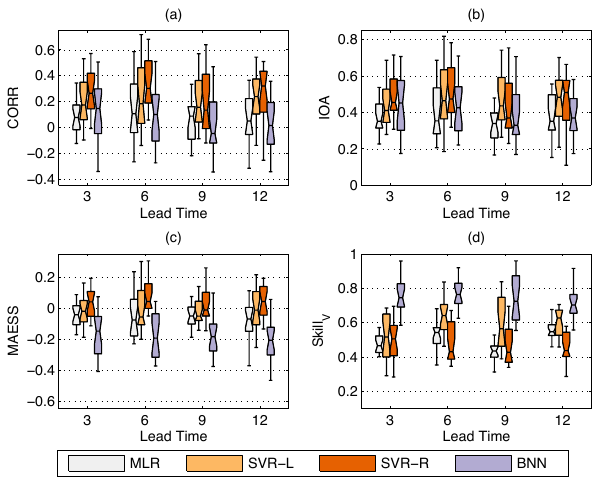
Fig. 3. Same as Fig. 2, except over the Cordillera (region R2).